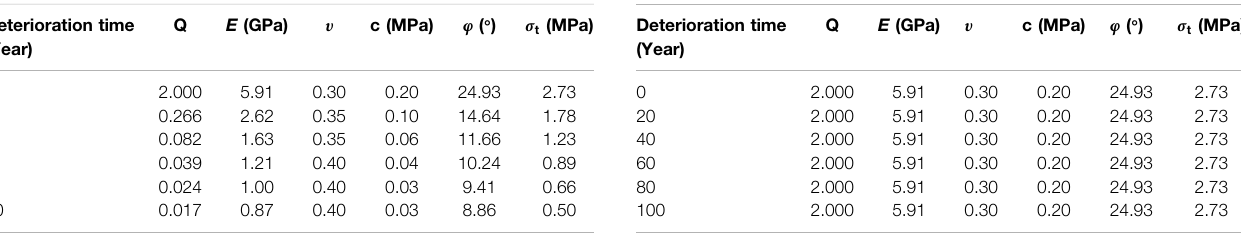
TABLE 5 | Time-dependent mechanical parameters of rock mass during deterioration.